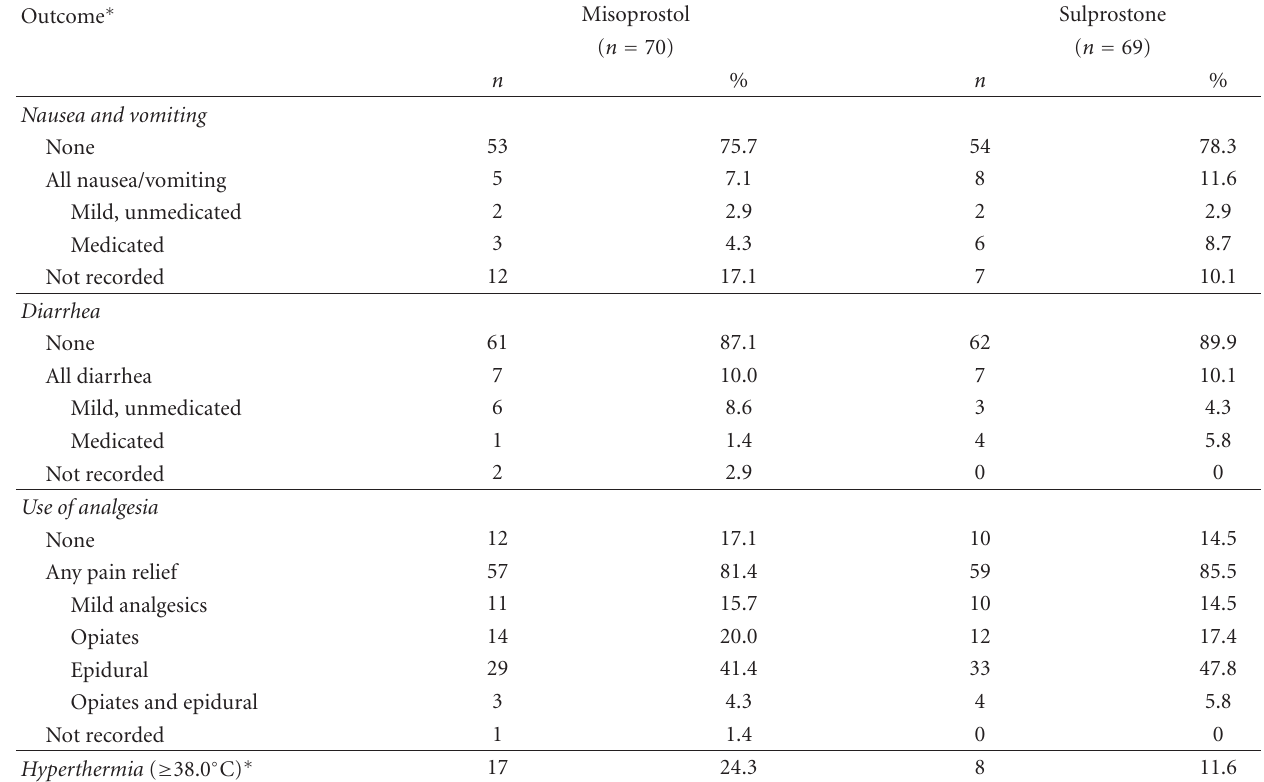
Table 3: Frequency of side e ff ects as recorded by the